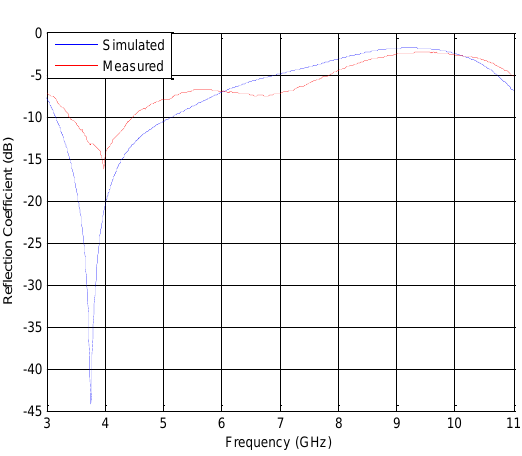
Fig. 4 : Reflection coefficient of Antenna-1.